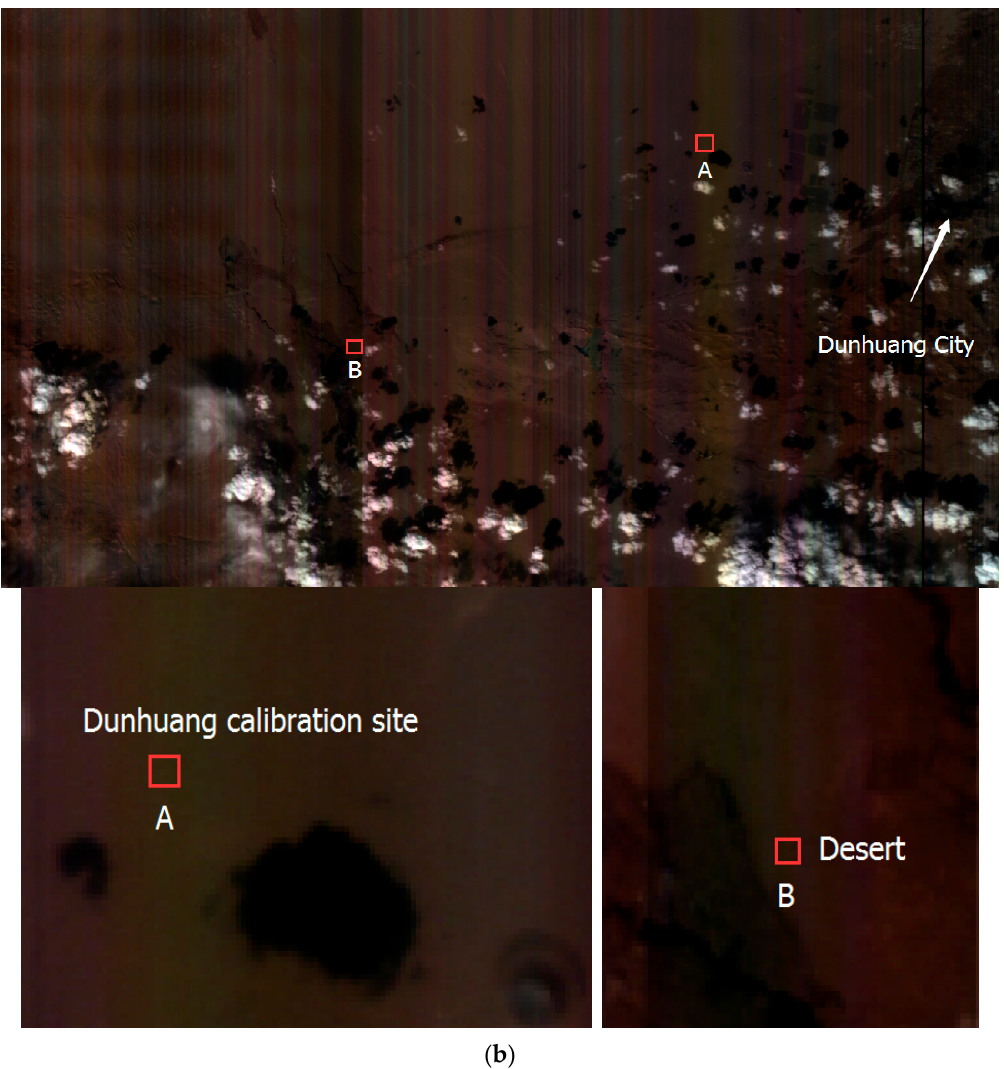
Figure 5. Subsets of SPARK-01 and -02 data acquired over the Dunhuang calibration site featuring pseudo color composited from the 141 (856.60 nm), 111 (648.60 nm) and 84 (550.30 nm) bands. ( a ) SPARK-01 data acquired on 7 March 2017 at 06:48:30 UTC. ( b ) SPARK-02 data acquired on 28 February 2017 at 06:52:32 UTC. These images were 180 ° rotated from the original raw data to maintain the northern and eastern directions on the top and the right hand, respectively. Table 2. SPARK image acquisition information at the Dunhuang calibration site.